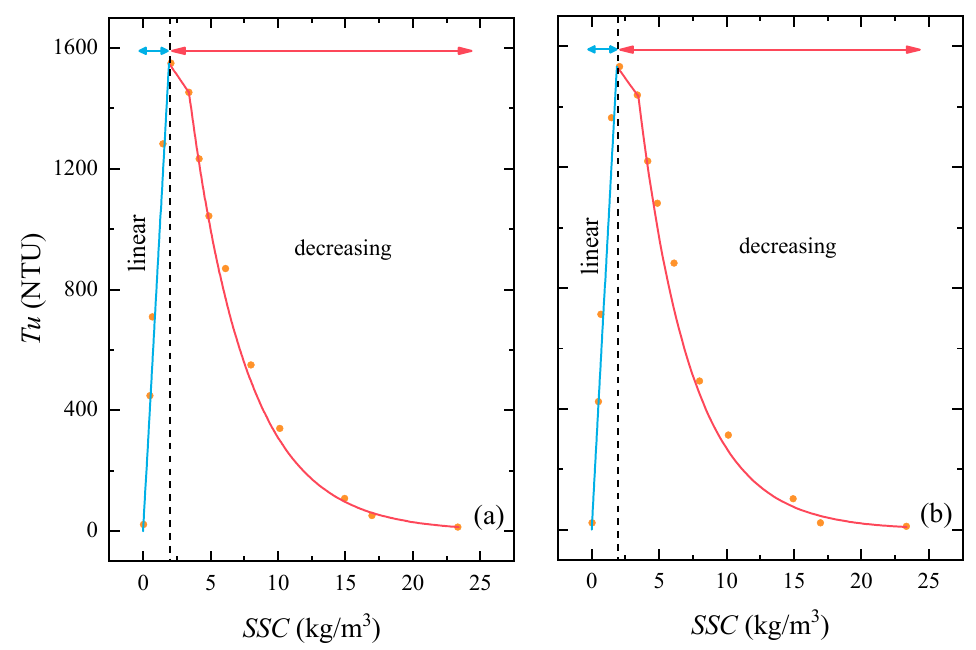
Figure 5. Laboratory calibration for RBR solo 3 Tu bonded to the anchored floater showing the response of Tu to SSC of the lab samples: ( a ) 0.5 H asb; ( b ) 0.9 H asb. H is the water depth.